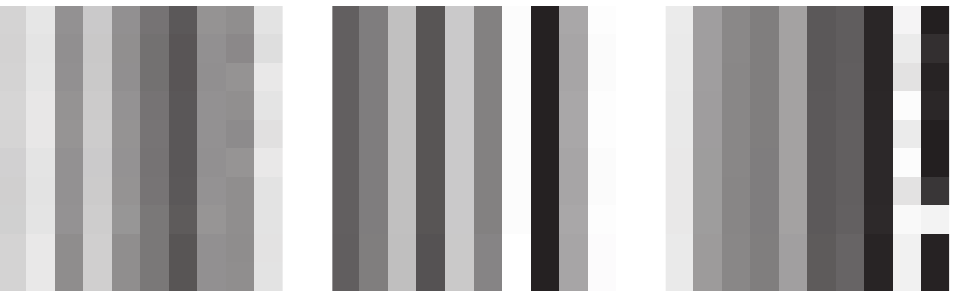
Figure 2. Angle of arrival (AOA) grayscale under different labels (Labels from left to right are ‘2-2’, ‘2-6’ and ‘2-10’